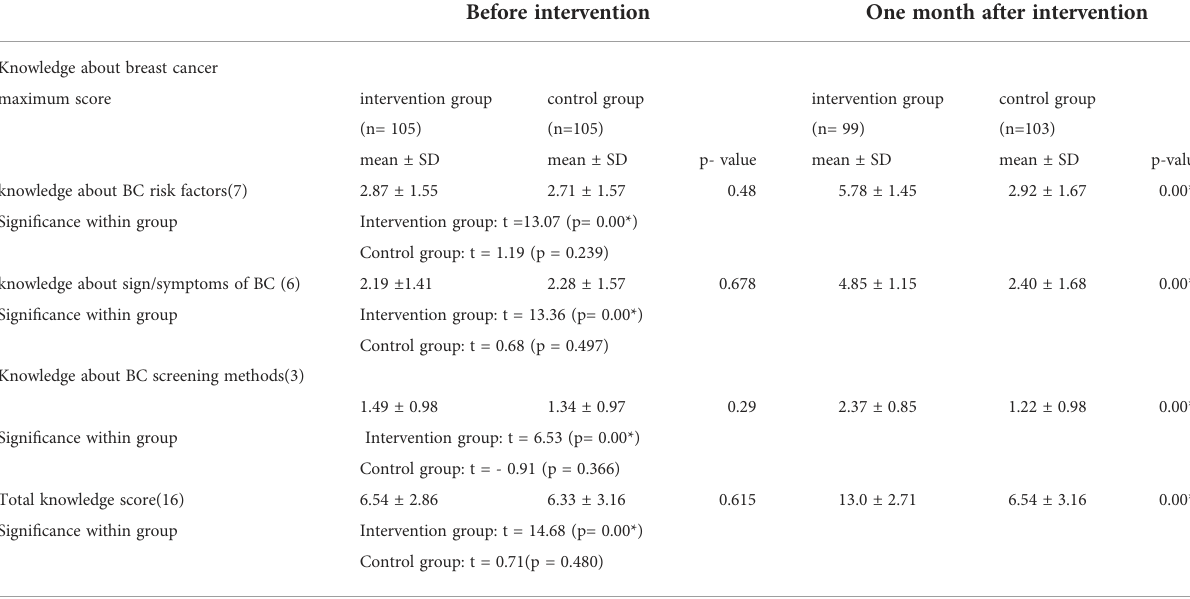
TABLE 2 Mean differences between the intervention and control groups ’ knowledge score regarding breast cancer among female students of Debre Markos University, Amhara, Ethiopia before and 1 month after educational intervention about BC based on HBM (n = 210) 2021. Before intervention One month after intervention Knowledge about breast cancer